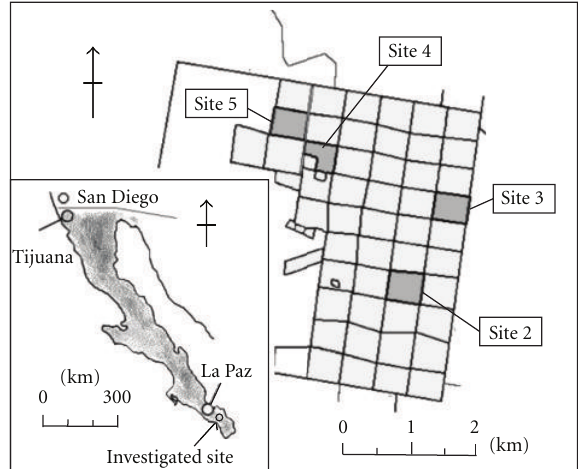
Figure 1: Location of the investigated farmlands. Site 1 is located at about 7 km southeast of Site